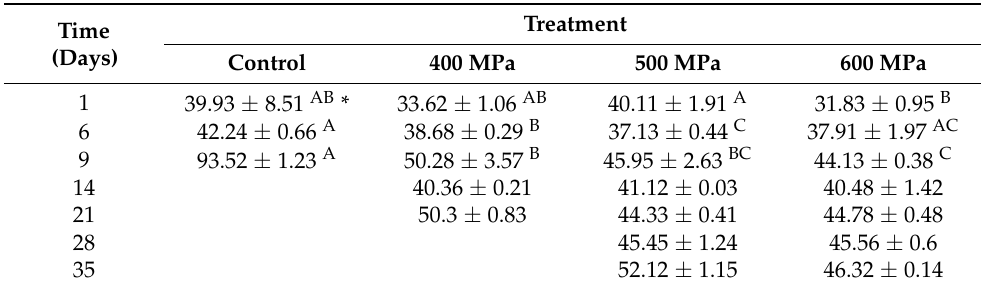
Table 1. K-values measured during chilled storage in striped prawns untreated (control) or treated by HHP at 400, 500, and 600 MPa.